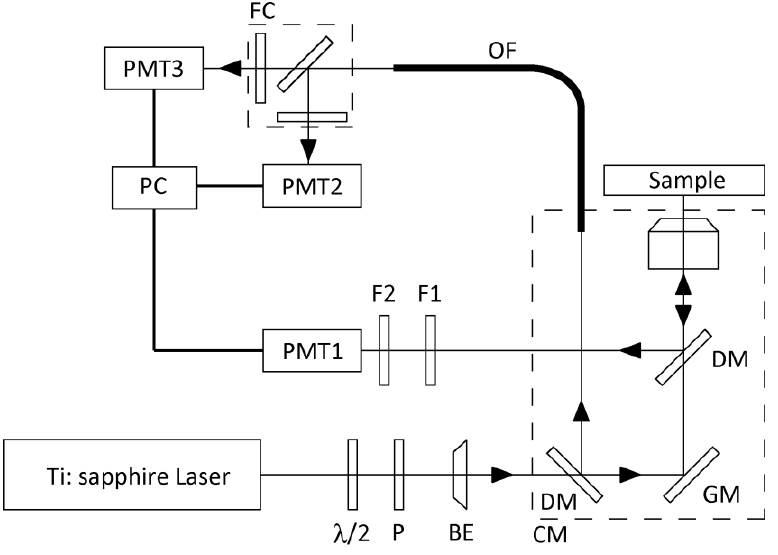
Fig. 1 Schematic view of optical setup.  /2: half wave plate, P: polarizer, BE: beam expander, CM: confocal microscope, DM: dichroic mirror, GM: galvano mirror, F1: band pass filter, F2: blue pass filter, OF: optical fiber, FC: filter cube, PMT: photomultiplier tube. PMT1, 2, and 3 detects SHG, green and red fluorescence, respectively.